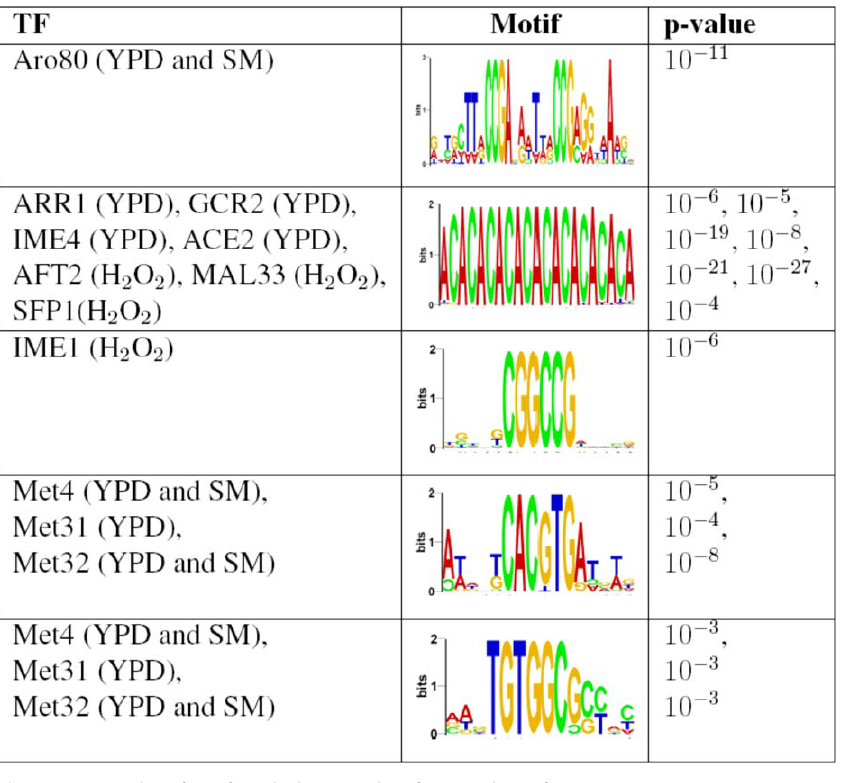
Figure 3. Examples of TFs for Which DRIM Identifies Novel Motifs We further investigated these motifs and show evidence of their biological function. YPD, H 2 O 2 , and SM denote the ChIP–chip experimental conditions [25] in which the motifs were